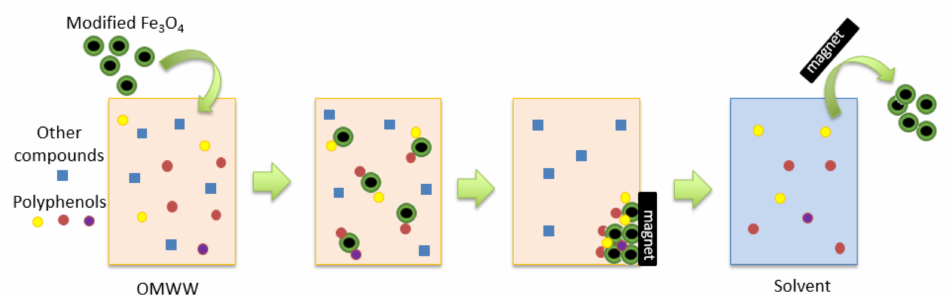
Figure 1. Scheme depicting the removal of polyphenols from olive mill waste water (OMWW) by the use of iron oxide (Fe 3 O 4 ) particles and desorption in a solvent. Polyphenolic compounds are indicated by circular shapes in various colours, other compounds are represented by squares.